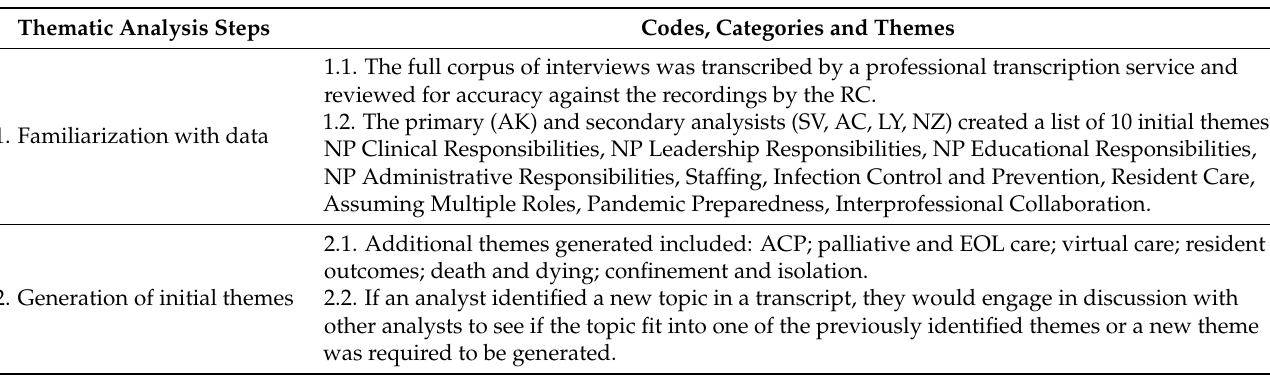
Table 2. Categories and themes related to the Nurse Practitioners’ role in facilitating a dignified death in long-term care homes during the COVID-19 pandemic using Thematic Analysis